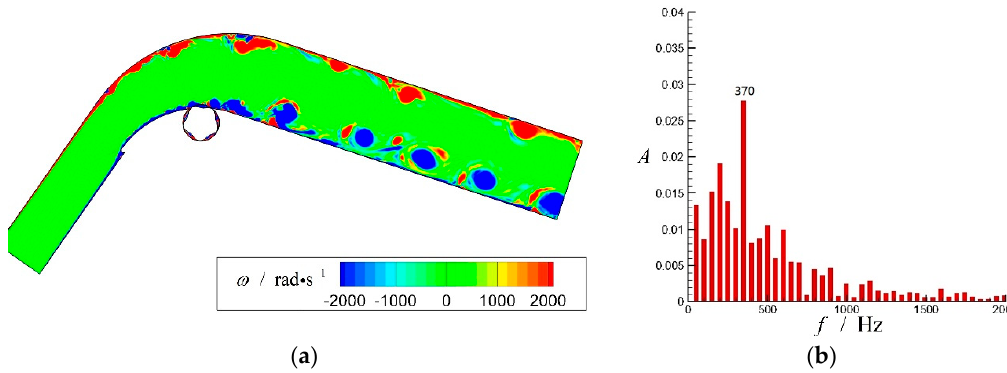
Figure 8. Numerical simulation of the diffuser with effective control ( (cid:101) V = 0.14, (cid:101) f = 1, and f TWW = 370 Hz): ( a ) Vorticity ( ω ) contour; ( b ) Velocity FFT of S2 ( A − f ).